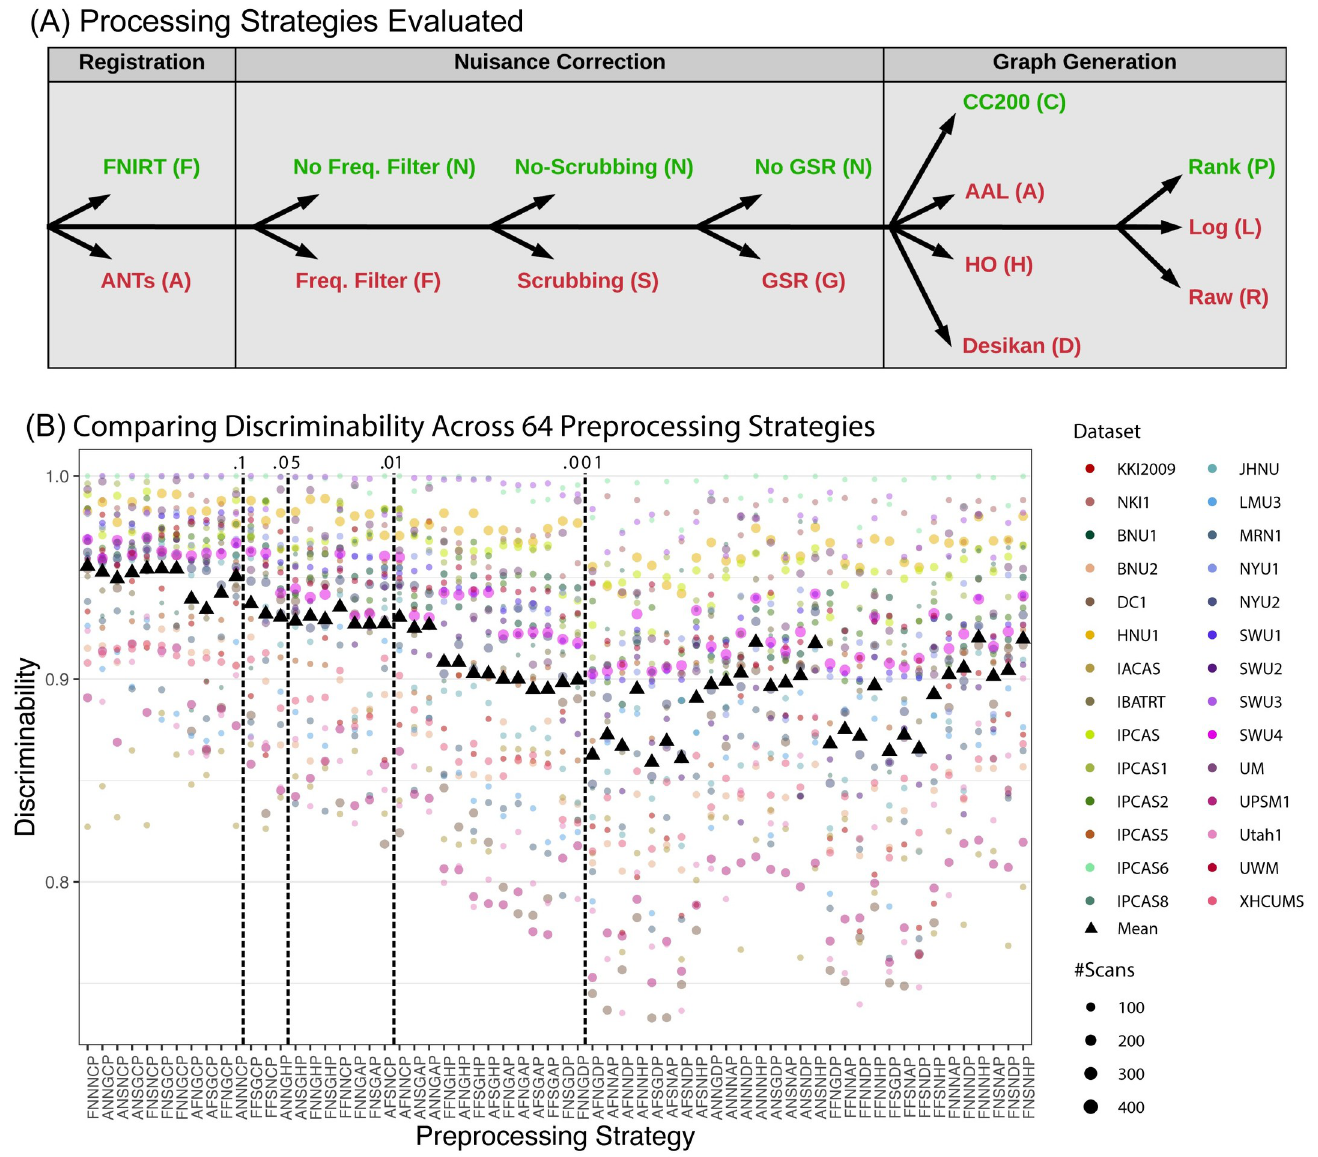
Fig 3. Different analysis strategies yield widely disparate stabilities. (A) Illustration of analysis options for the 192 fMRI pipelines under consideration (described in S6 Text). The sequence of options corresponding to the best performing pipeline overall are in green. (B) Discr of fMRI Connectomes analyzed using 64 different pipelines. Functional correlation matrices are estimated from 28 multi-session studies from the CoRR dataset using each pipeline. The analysis strategy codes are assigned sequentially according to the abbreviations listed for each step in (A) . The mean Discr per pipeline is a weighted sum of its stabilities across datasets. Each pipeline is compared to the optimal pipeline with the highest mean Discr , FNNNCP , using the above comparison hypothesis test. The remaining strategies are arranged according to p -value, indicated in the top